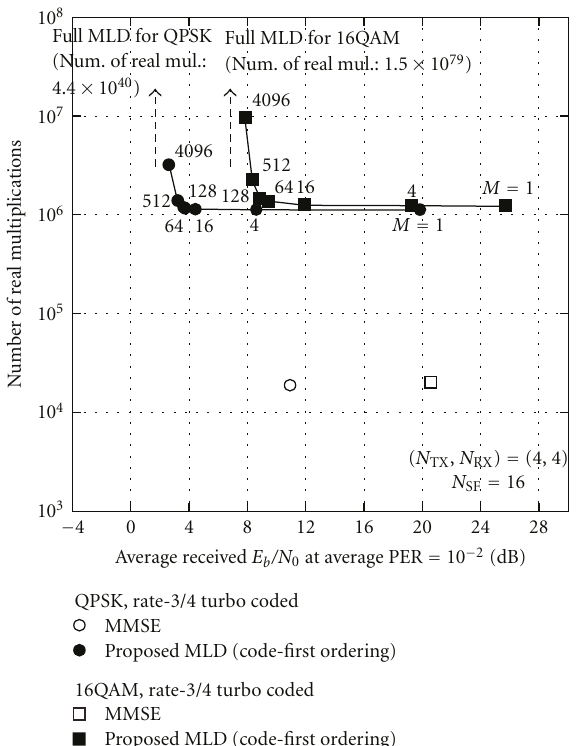
Figure 10: Number of real multiplications as a function of required average received E b /N 0